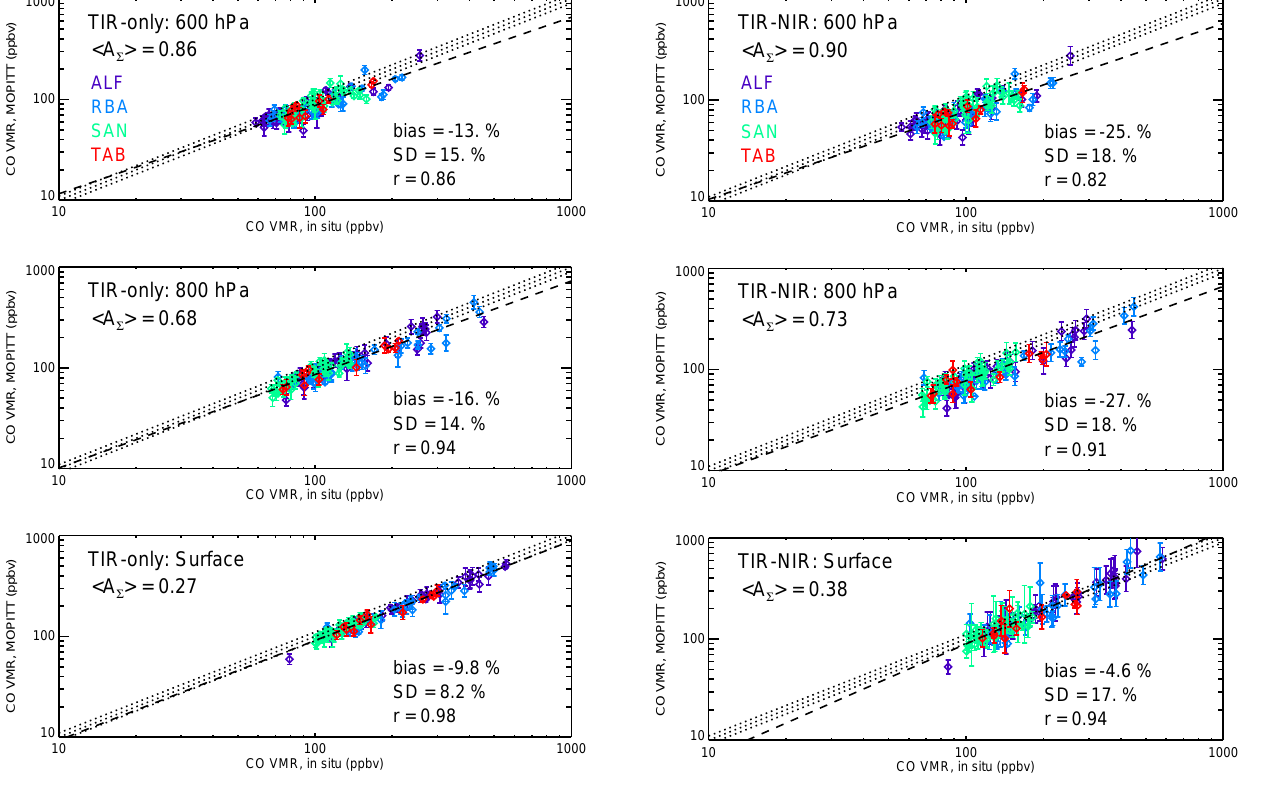
Figure 5. MOPITT Version 6 TIR-NIR validation results for MO- PITT mid- and lower-tropospheric CO retrievals based on aircraft profiles acquired at four Amazonian sites. See caption to Fig.